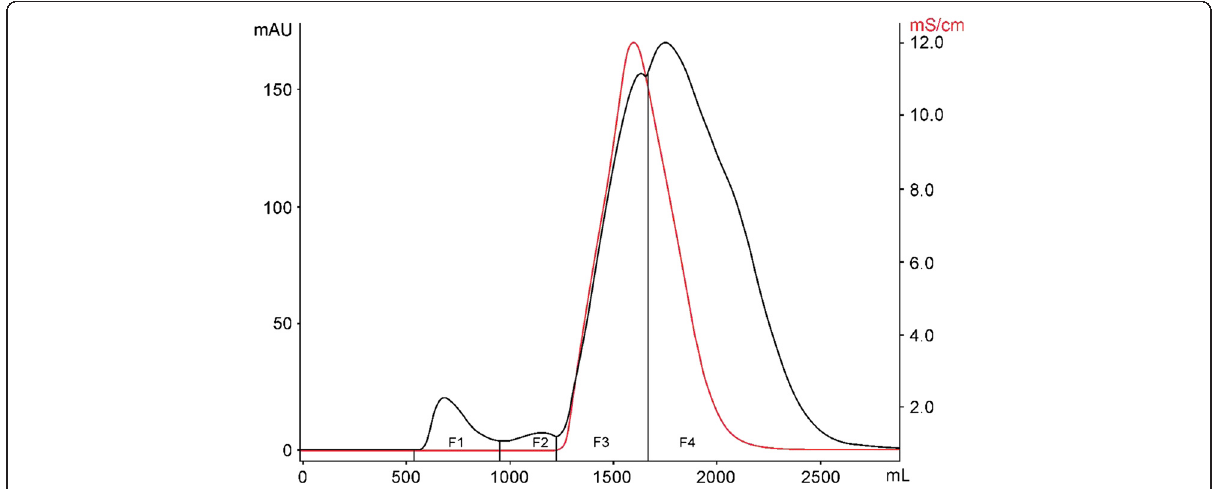
Figure 1 Gel filtration chromatography Sephadex G-50 M of CV (4 g) from B. globulifera . The column was equilibrated and eluted with 0.3 M acetic acid buffer at a flow rate of 2 mL min -1 to obtain the fractions F1, F2, F3 and F4.